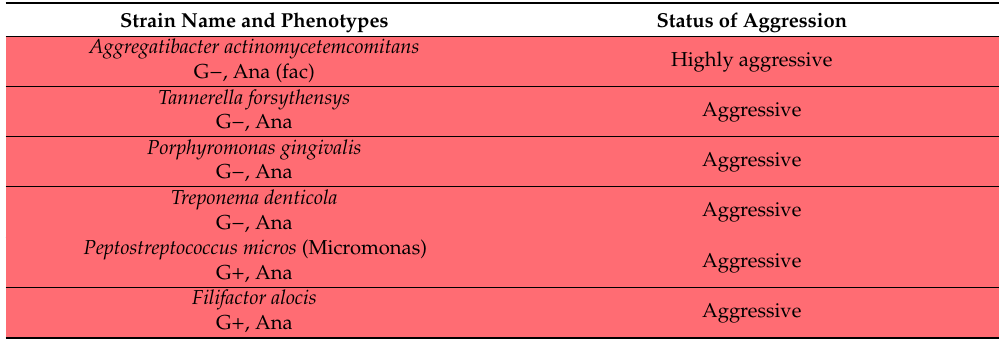
Table 2. The main periodontal pathogens responsible of oral disease, include Gram-positive and Gram-negative bacteria, facultative, and anaerobic / aerobic